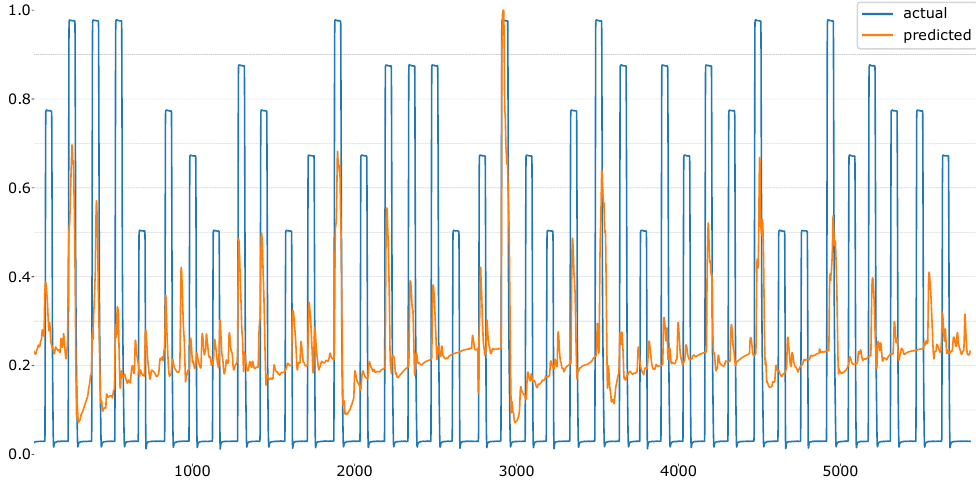
Figure 11. LOSO regression using the temperature values as